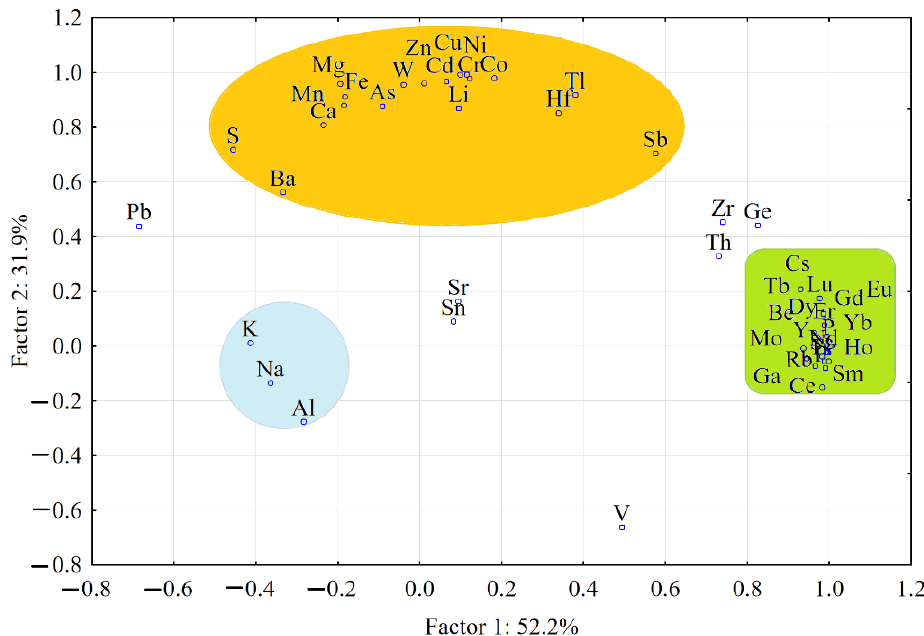
Figure 5. Two-dimensional Varimax-rotated PCA showing the grouping and interrelationships between the elements in the silty soil samples collected from Clo ș ani Cave.